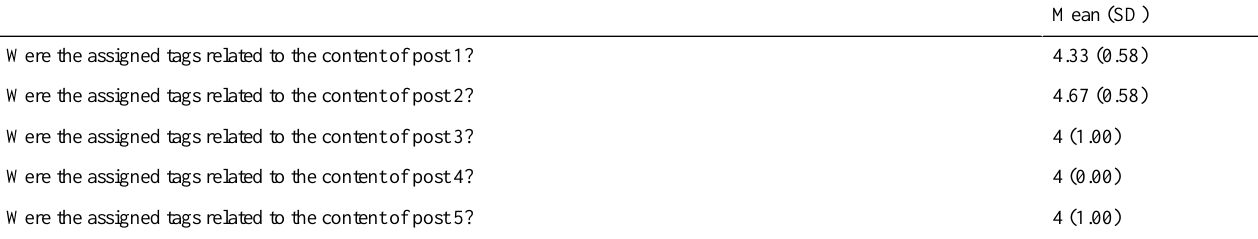
Table 10. Relatedness of the most commonly used tags to the aggregated cardiology